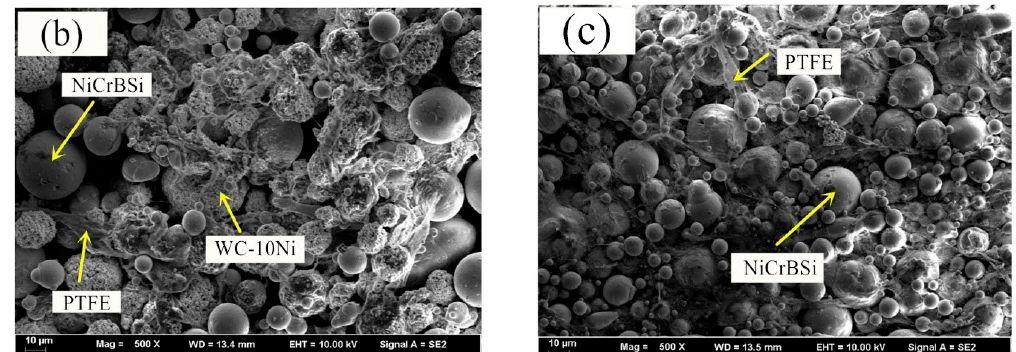
Figure 2. ( a ) Macro appearance of metal cloth; ( b ) microscopic morphology of “Solder cloth”; ( c ) microscopic morphology of “Carbide cloth”.